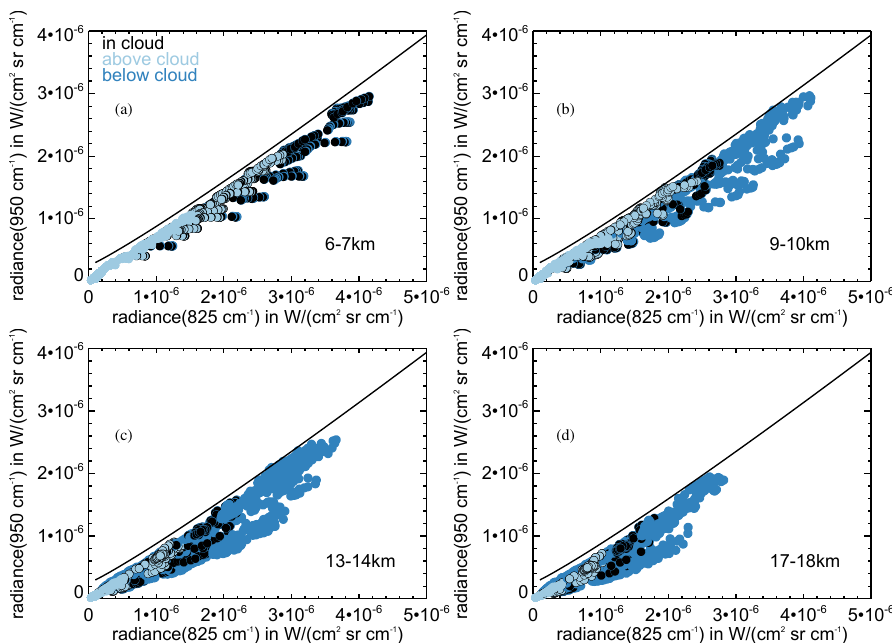
Figure 9. Simulated radiances for ice clouds. (a) Ice cloud at 6–7km altitude in polar winter, polar summer and mid-latitude atmosphere. (b) Ice cloud at 9–10km altitude in polar winter, polar summer and mid-latitude atmosphere. (c) Ice cloud at 13–14km altitude in polar winter, mid-latitude, and equatorial atmosphere. (d) Ice cloud at 17–18km altitude in polar winter and equatorial atmosphere. The black line is the ash detection threshold. The tangent altitudes below the cloud down to 7km altitude are coloured in blue, the tangent altitudes within the cloud are coloured in black, and tangent altitudes above the ice cloud are coloured in light blue.